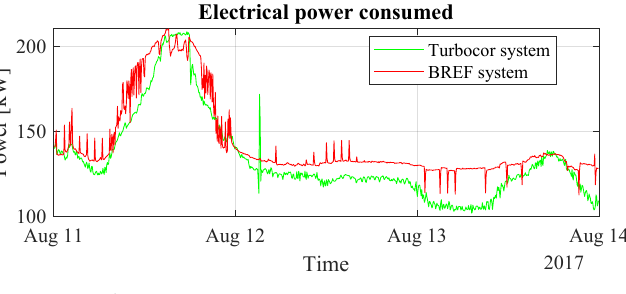
Figure 15. Electric power consumption on 11–13 August 2017. Table 5. Parameters of the power consumption profiles on 11–13 August 2017.